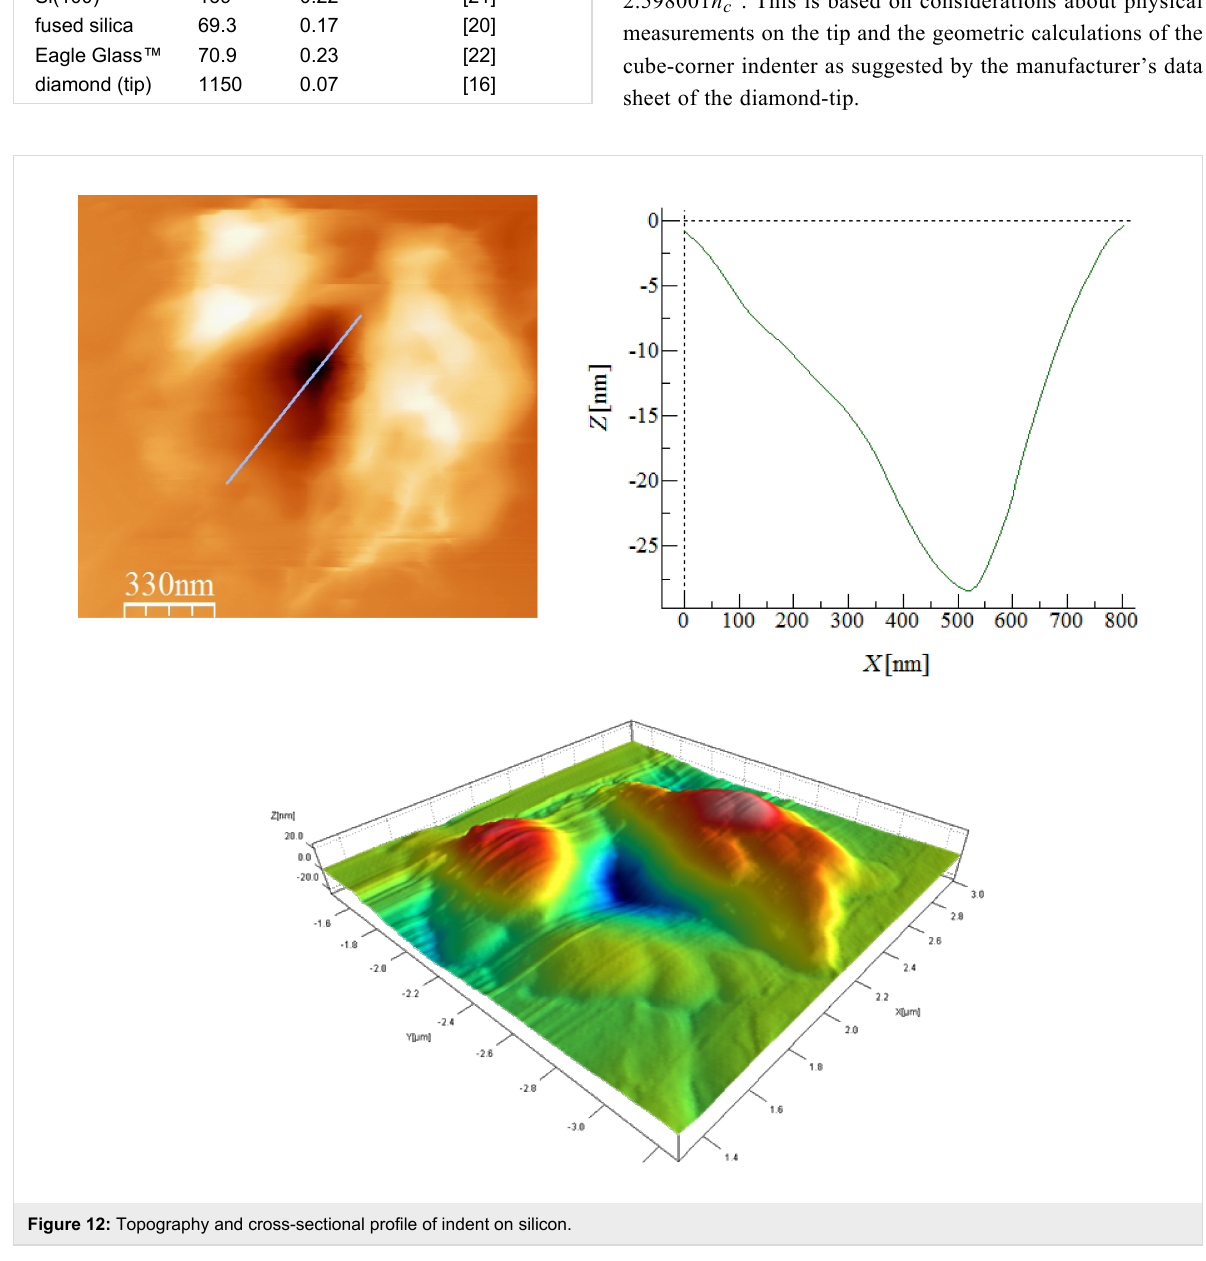
Figure 12: Topography and cross-sectional profile of indent on silicon.